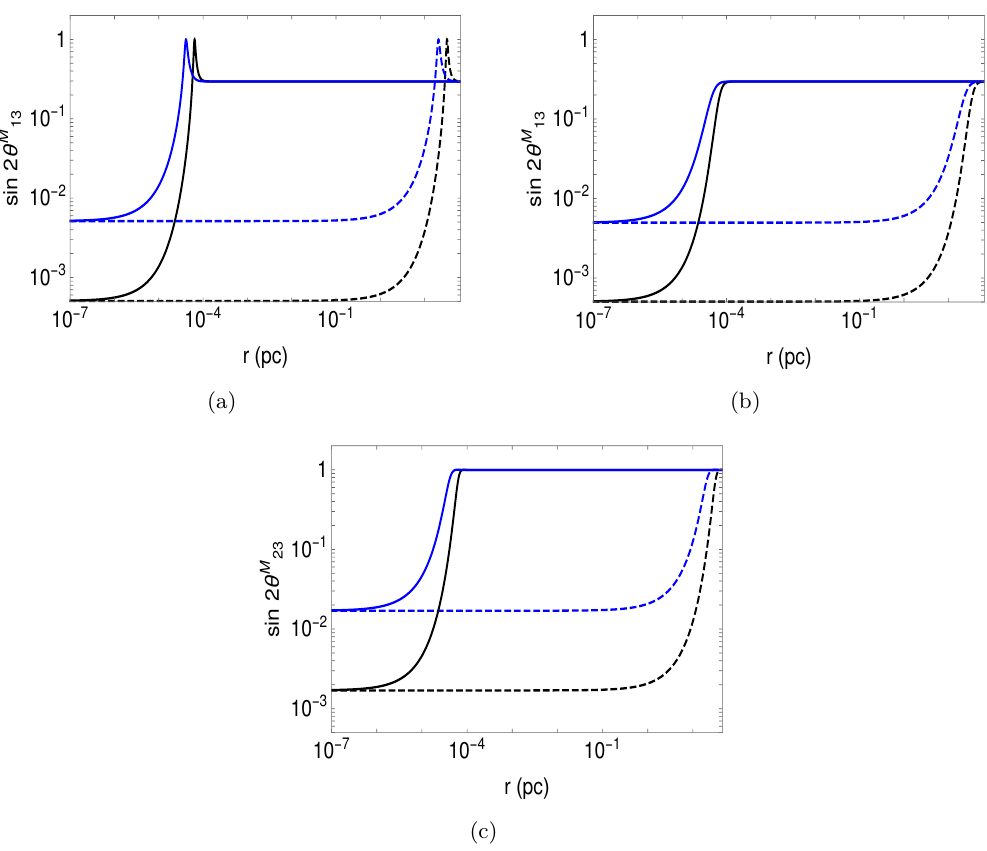
Figure 2 . sin 2 θ M vs. radial distance at source with ρ 0 = 7 . 4 × 10 − 3 eV 4 and G 0 /m DM = 10 − 13 eV − 3 F for (a) positive V , (b) negative V and (c) negative V . The dashed (solid) line represents a = 5 ττ ττ ττ pc ( 10 − 5 pc), whereas the black (blue) line represents E = 1 PeV (100 TeV). Here, E is the S S energy at the source situated at z = 2 .